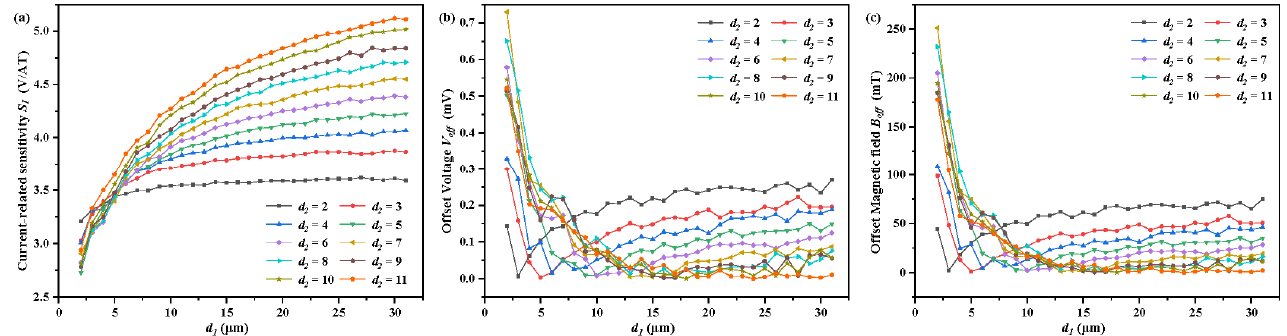
Figure 8. Current-related sensitivity S I ( a ), offset voltage V off ( b ), and offset magnetic field B off ( c ) of d 1 from 2 to 31 μm with the length l and d 3 set to 90 μm and 24 μm, respectively.